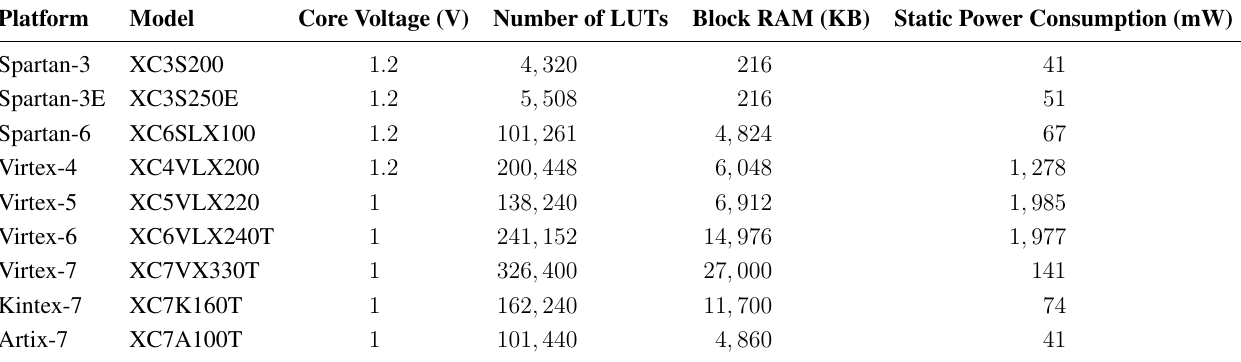
Table 1. Power consumption and operating voltage of Xilinx